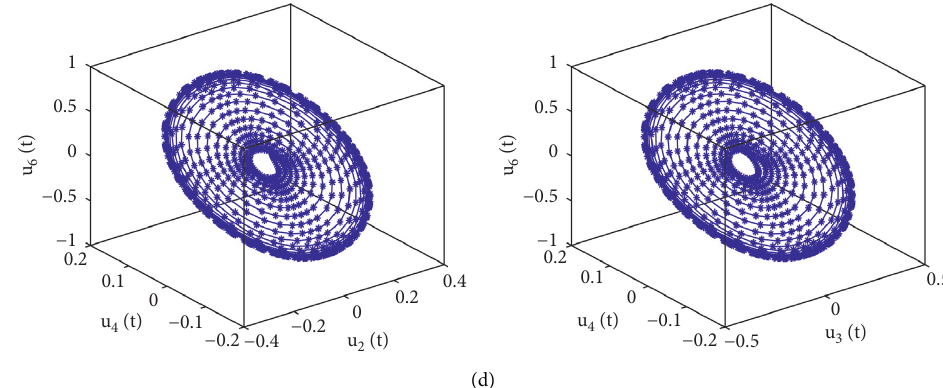
Figure 2: Hopf bifurcation for neural network model (46) involving ζ � 0 . 9 > ζ